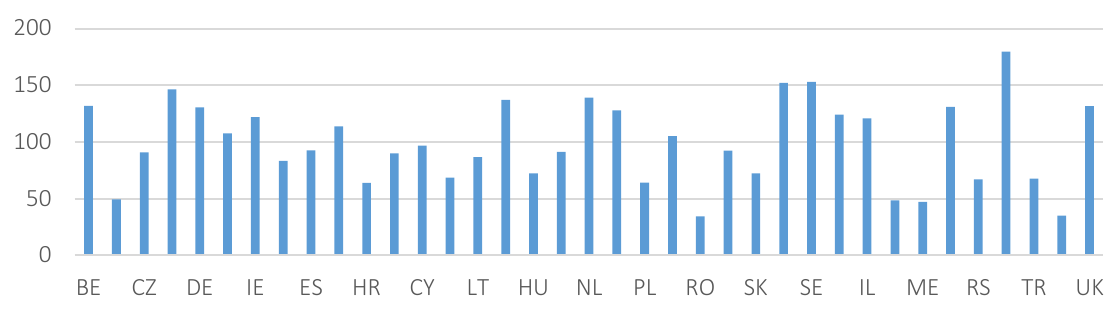
Figure 1. European innovation scoreboard